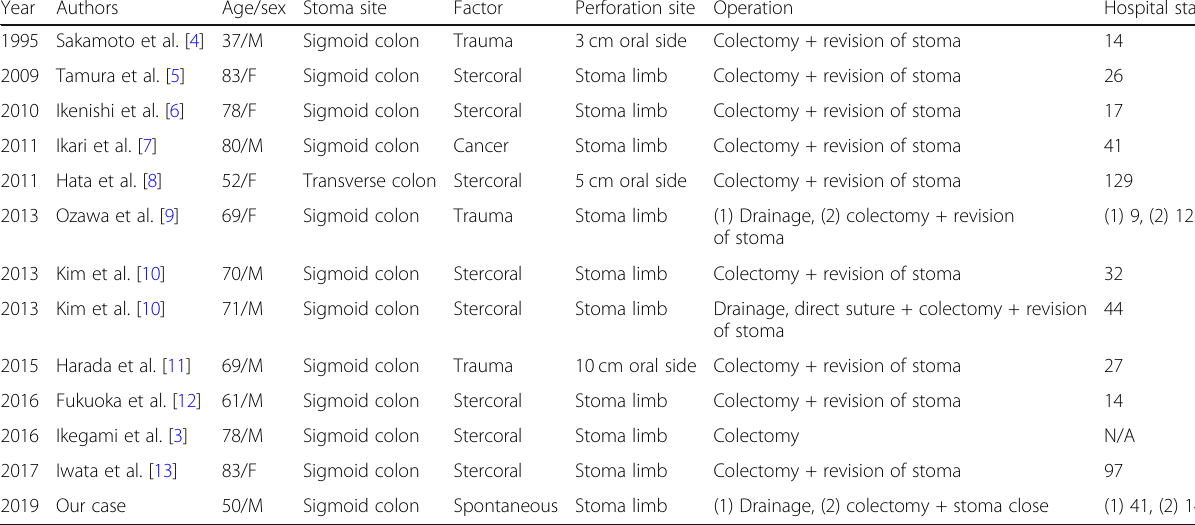
Table 2 Search results of published case reports from April 1995 to December 2019 in the Japan Medical Abstracts Society and in PubMed database using the keywords “ spontaneous perforation ” or “ stoma limb perforation